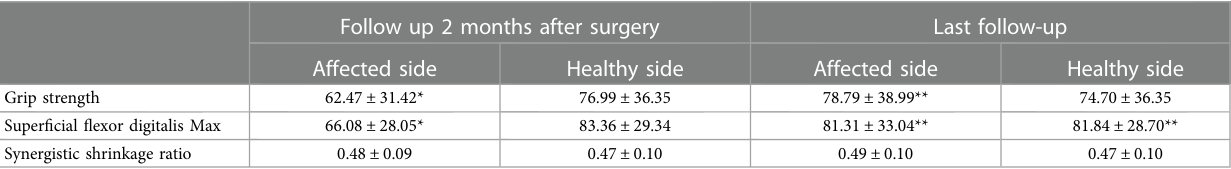
TABLE 3 The mean value (µV) of surface electromyographic signal (RMS) and synergistic shrinkage ratioof the super fi cial fl exor and digital extensor muscles of the affected and healthy sides during maximum voluntary fl exion and extension of the wrist in children with ulnar radius fracture at 2 months and the last